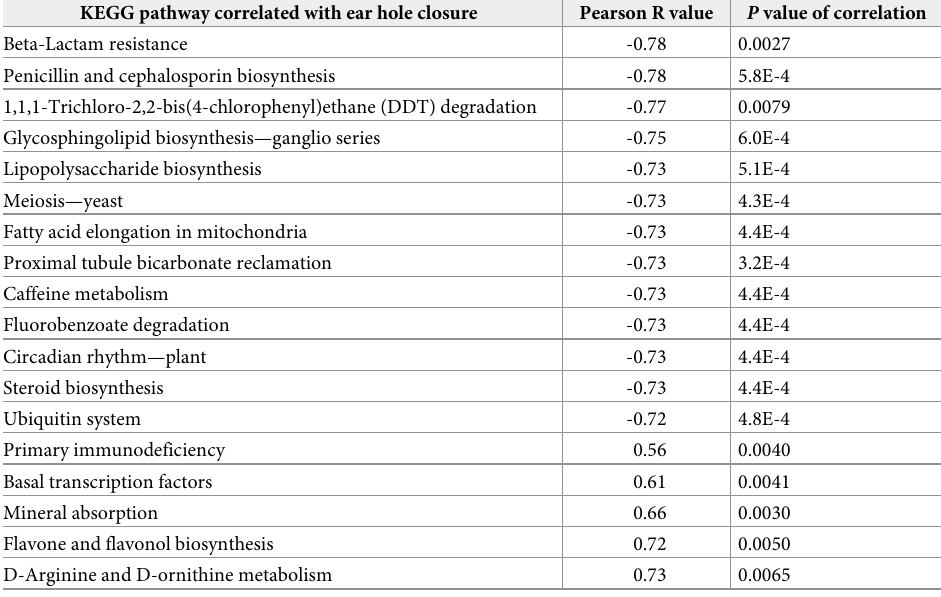
Table 2. Top imputed microbiome metagenomes correlated with ear hole closure among B6-vehicle, MRL-trans- planted B6, and MRL-vehicle mouse groups. KEGG pathway correlated with ear hole